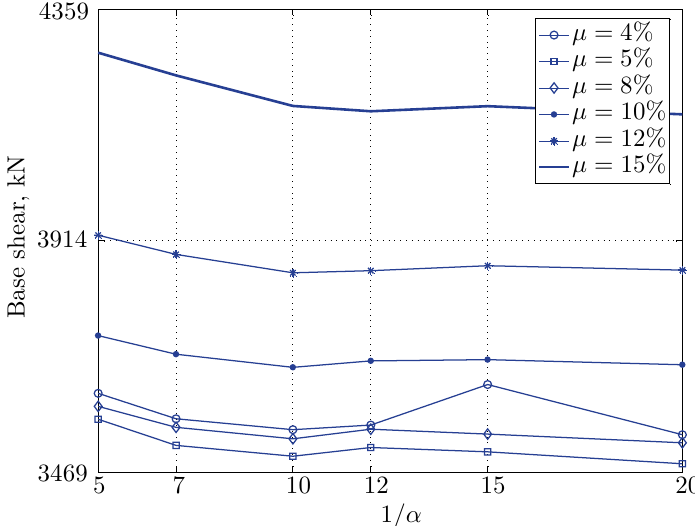
Figure 19. Maximum base shear for various isolation system parameters (Hollister).